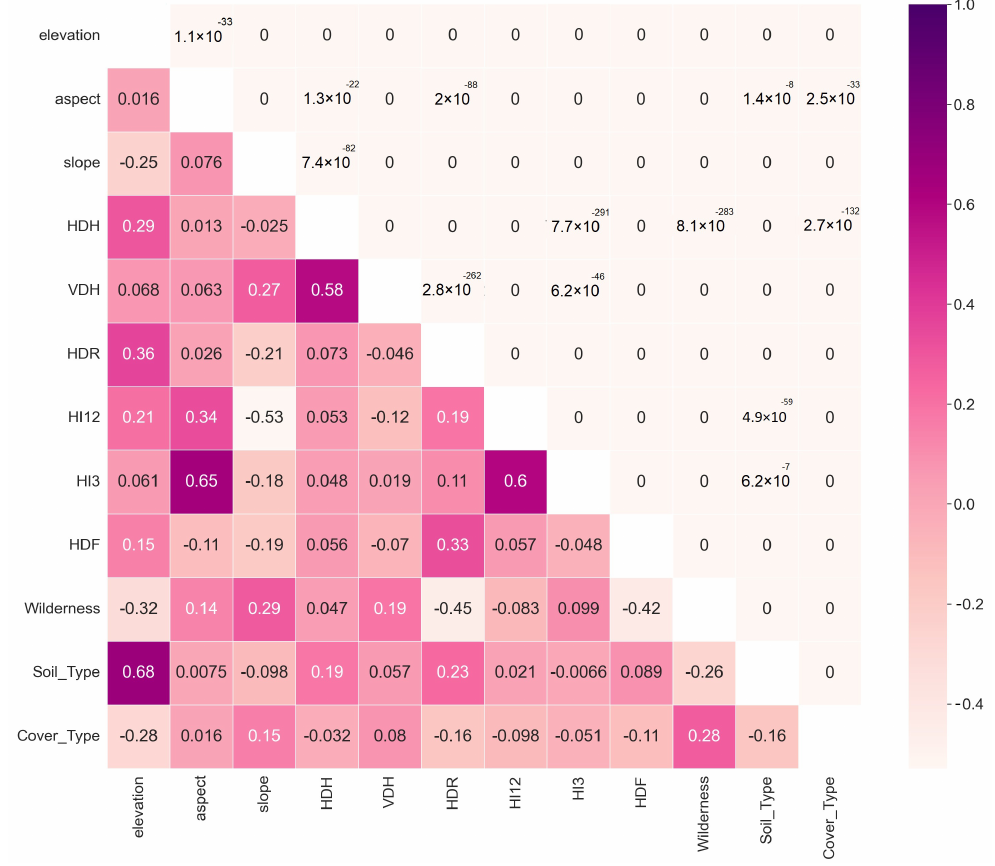
Figure 2. Feature correlation matrix (Pearson), with r below and p -value above the